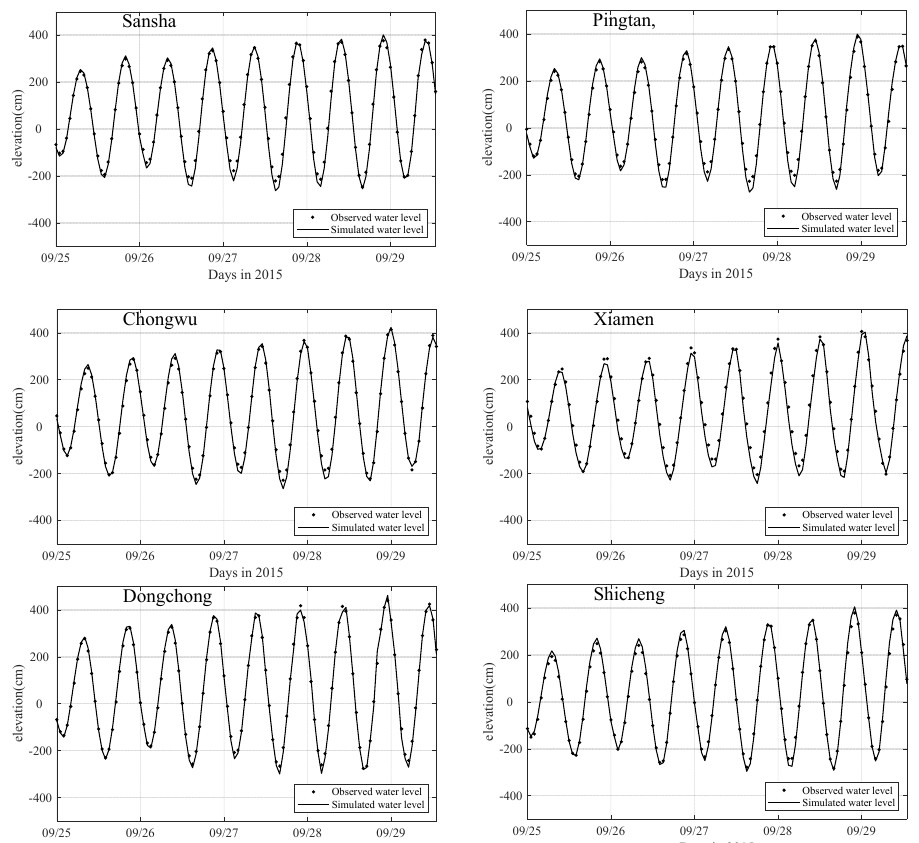
Figure 3. Comparison of water level simulations and observations along the Fujian coast during Typhoon Usagi .